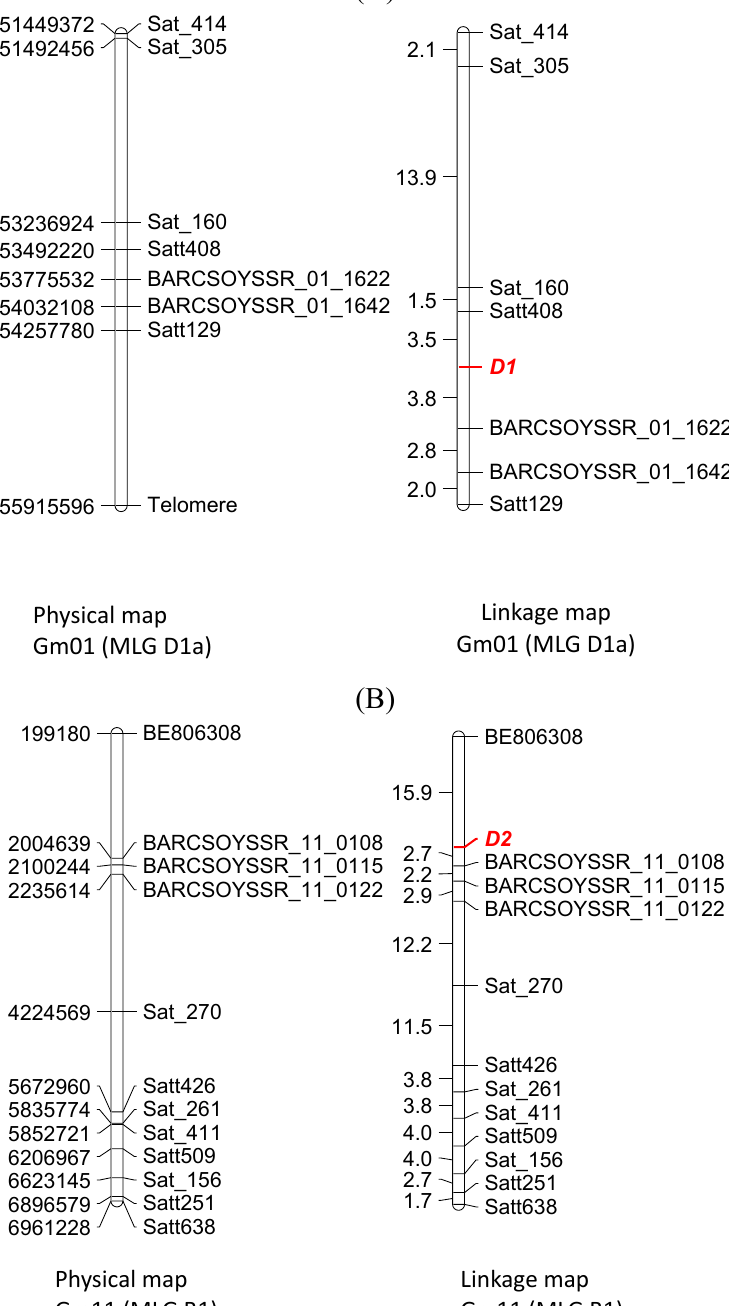
d d d ; L69-4267). ( A ) Genetic and physical maps 1 1 2 2